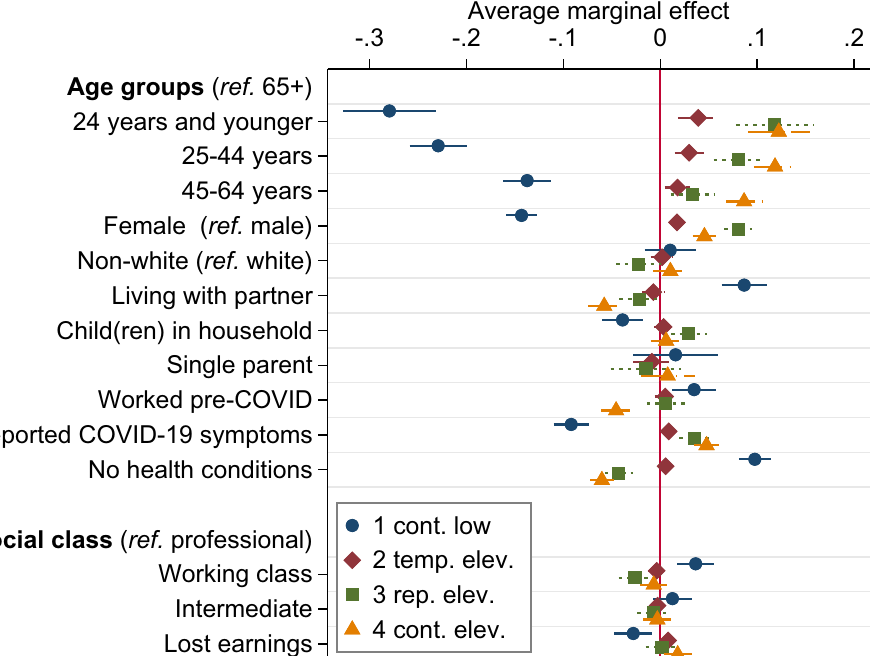
Figure 2. Average marginal effects (AMEs) of multinomial regression model of trajectory membership. Notes: Average change in a trajectory’s probability when a covariate increases by one unit, from multinomial model with the trajectories of psychological distress as the outcome: (1) continuously low, (2) temporarily elevated, (3) repeatedly elevated, (4) continuously elevated. Error bars represent 95% confidence intervals. AMEs for region, household earnings, and missing earnings not shown. Based on Understanding Society COVID-19 Study ( N = 13,920